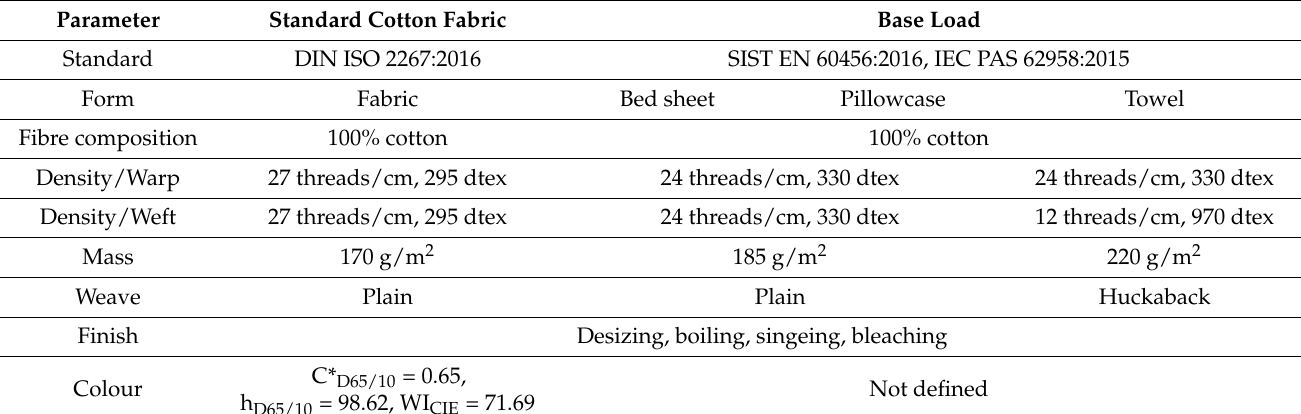
Table 3. Characteristics of the used fabric and base load